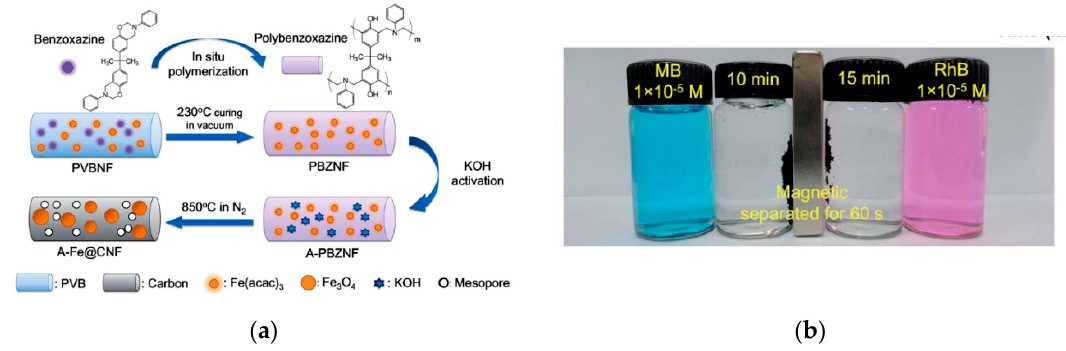
Figure 12. Scheme of the in situ polymerization method for the synthesis process of A-Fe@CNFs ( a ), image of the nanofibers after adsorption of MB (10 min) and RhB (15 min) ( b ) (Reproduced with permission from [78]. Copyright The Royal Society of Chemistry, 2012).